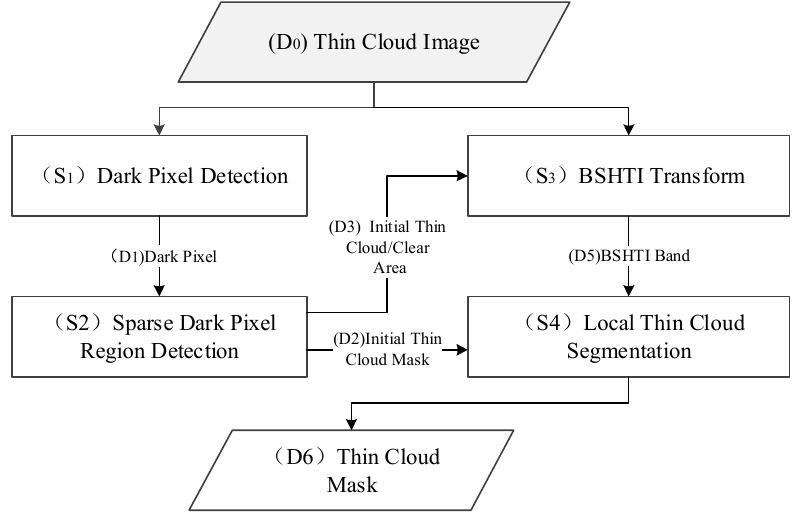
Figure 1. The flowchart of the proposed method. BSHTI—background suppression haze thickness index.